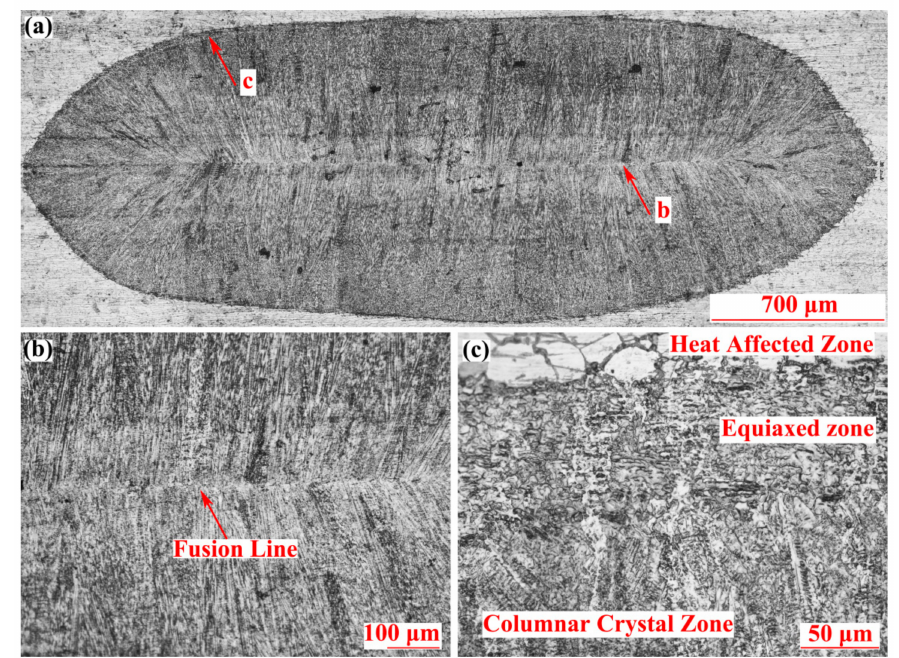
Figure 5. Metallographic morphology of nugget on the vertical cutting section: ( a ) overall perspective, ( b ) morphology of fusion zone, and ( c ) morphology on the nugget lower side.